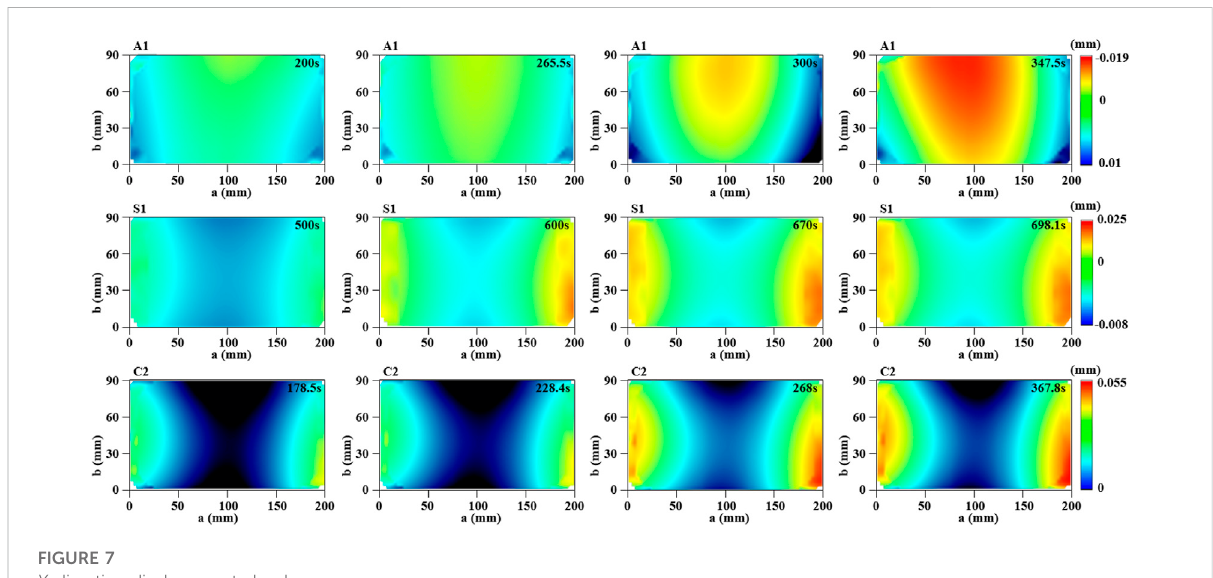
FIGURE 7 Y -direction displacement cloud